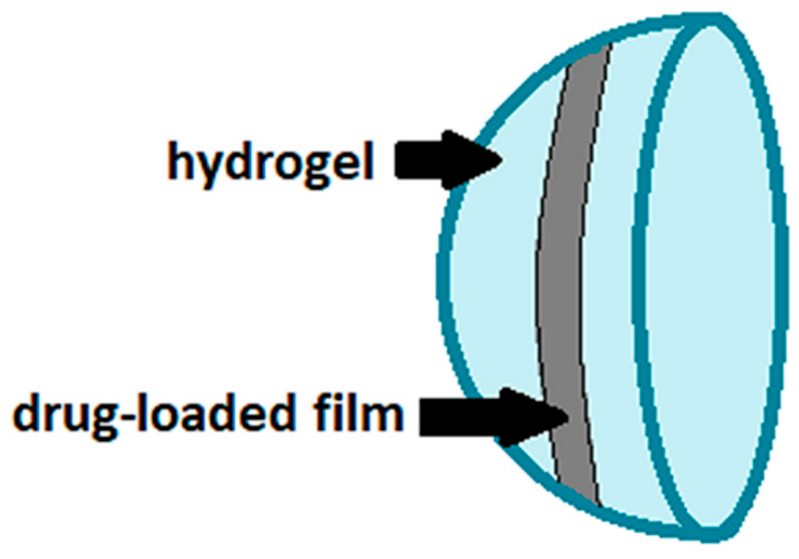
Figure 3. Drug-loaded film incorporated into hydrogel-based contact lenses.